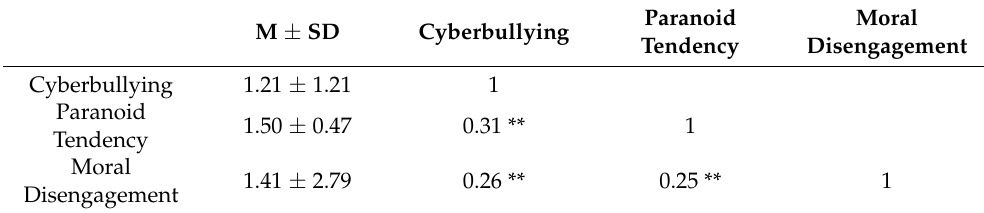
Table 2. Descriptive statistics and